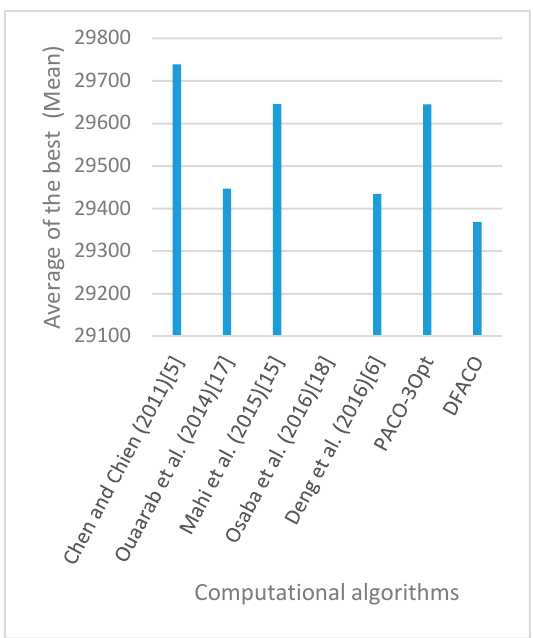
Figure 20. Average of best solutions obtained for instance kroA200 by all algorithms.